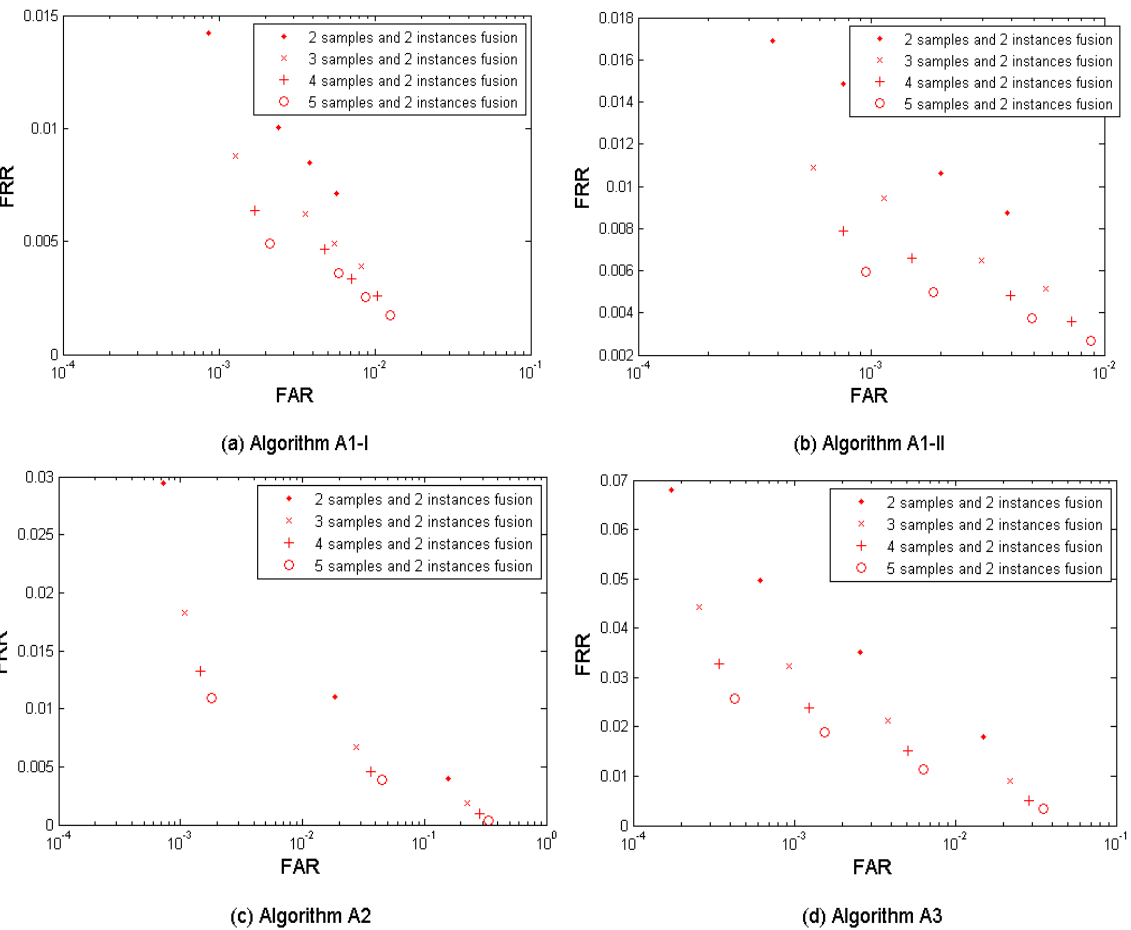
Figure 9. Multi-sample-instance fusion results from the left and the right index